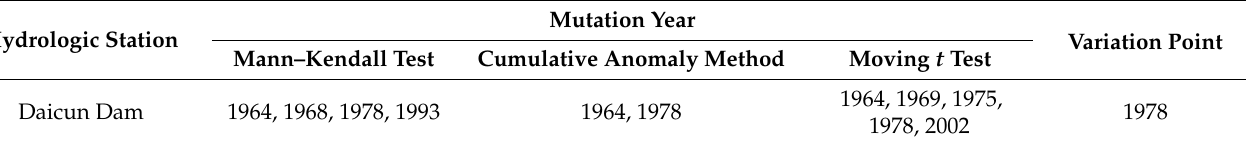
Table 2. Result of the mutation test of annual measured runoff of Dawen River.